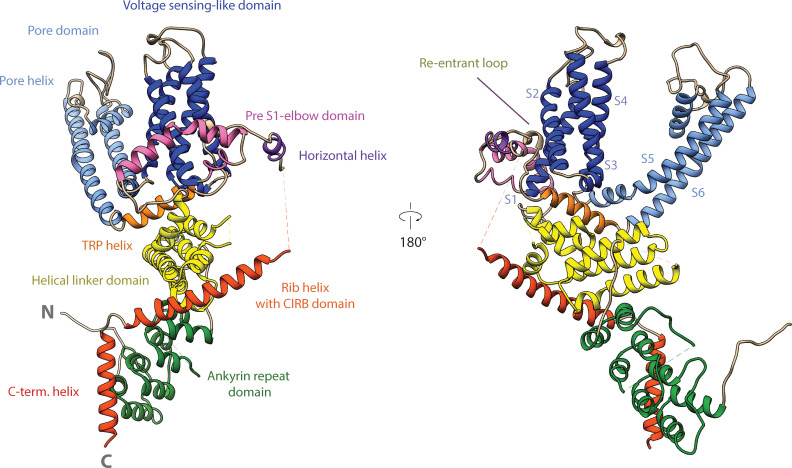
Domain architecture of zebrafish TRPC4 channel.Cartoon representation of a TRPC4 protomer. Each domain is shown in a different color and labeled accordingly.